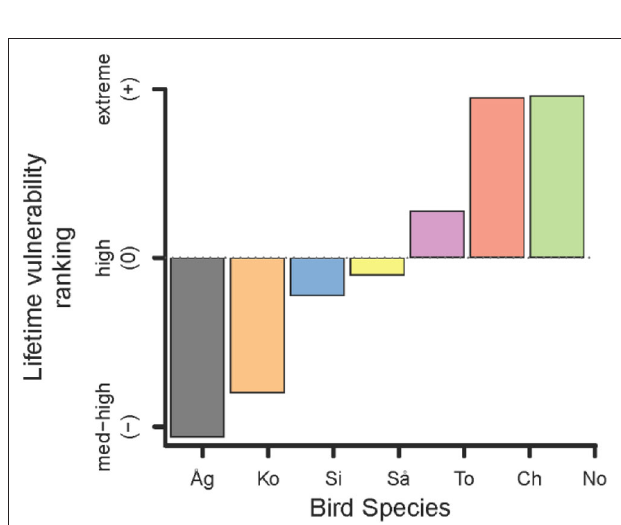
FIGURE 4 | Relative vulnerability ranking of avifauna found by integrating both dimensions of predation risk (encounter and death on encounter) over an average bird’s lifespan. Scale of differences depend on probability of BTS encounter (in order of increasing vulnerability: Åg = Åga, Ko = Ko ' ko ' , Si = Sihek, Så = Såli, To = Totot, Ch = Chichirika, No = Nosa '